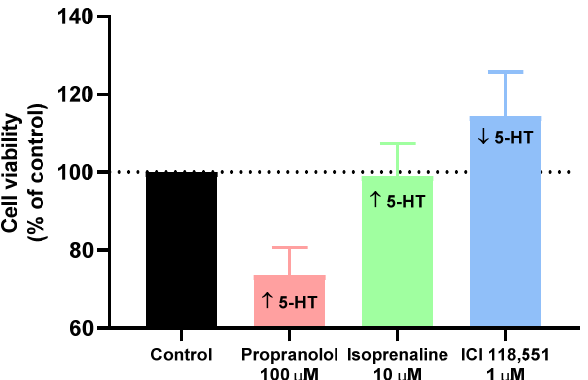
Figure 10. Relationship between cell viability and endogenous 5-HT values of MCF-7 treated with propranolol, isoprenaline, and ICI 118,551. Values of cell viability obtained by MTT assay. The results are shown as the percentage of control and are expressed as the mean ± SD of three independent experiments.